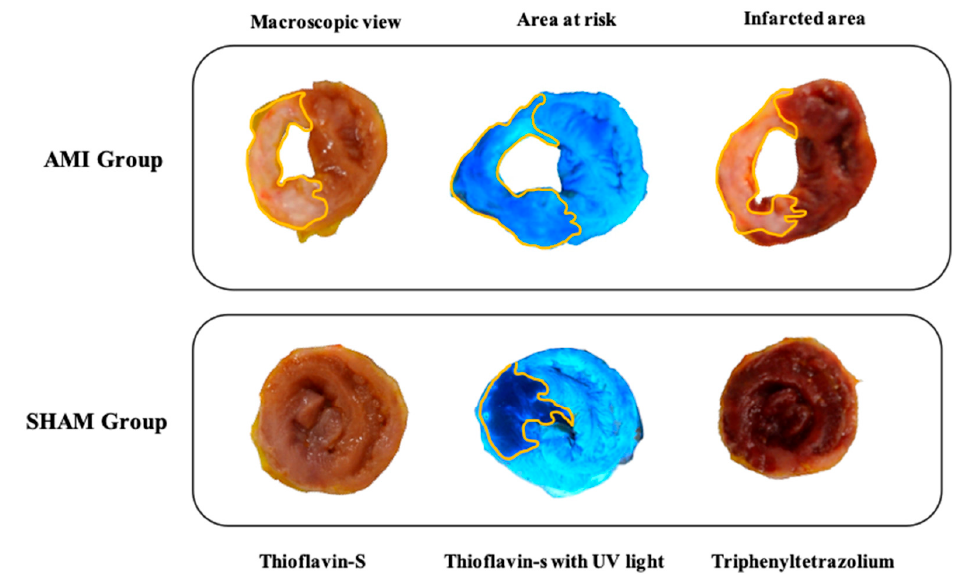
Figure 5. Images from an example of a tissue section for each group (acute myocardial infarction (AMI) and sham) where it is observed the staining of thioflavin-S without ultraviolet (UV) light for macroscopic observation, thioflavin-S with ultraviolet light for determining the area at risk, and triphenyltetrazolium chloride for determining the infarct